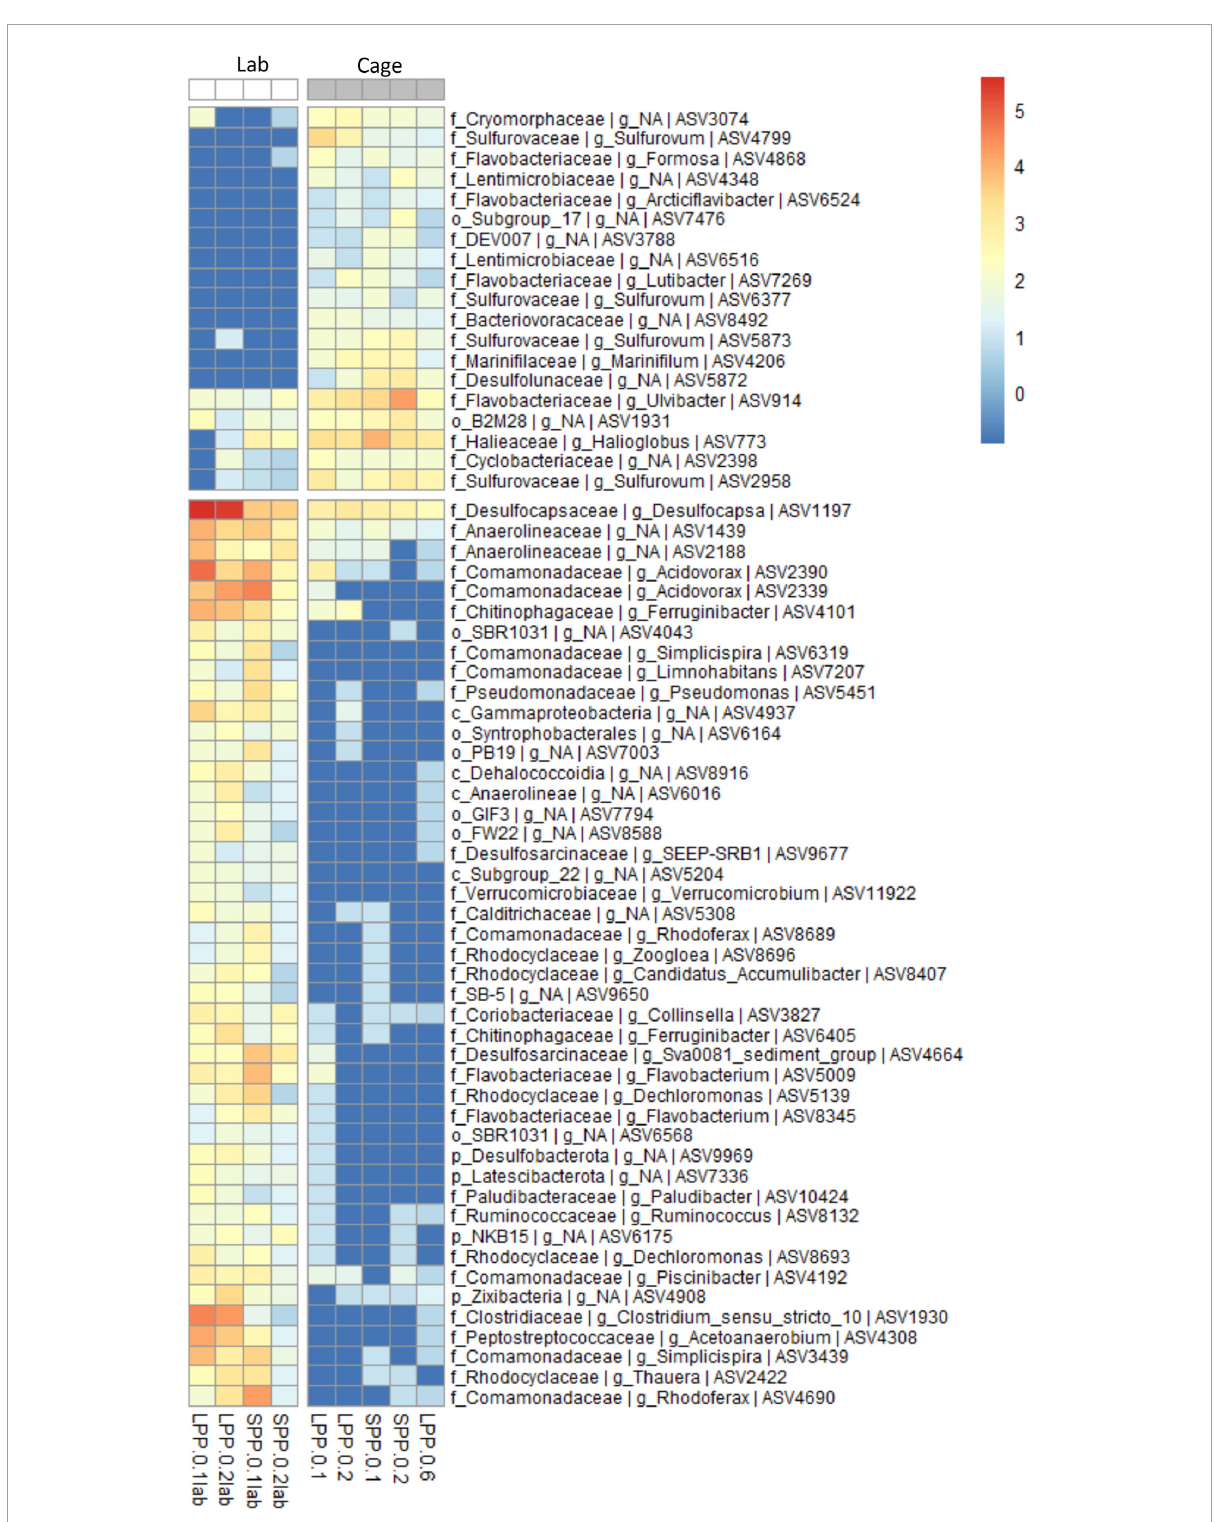
FIGURE4 Correlation analysis between the microbial communities in cage sediments from the field and from lab incubations (Spearman correlation, p < 0.001). ASV abundance is normalized with variance stabilizing transformation (blue to red scale bar). Genus and next known taxonomic level are stated for each ASV (k, Kingdom; p, Phylum; o, Order; c, Class; f, family; g, Genus). Sample code represent production period: LPP, long; SPP, short; distance from: 0 = at cage; and sediment layer: 1 = 0–0.5 cm, 2 = 0.5–1.0 cm, 6 = 3.0–5.0